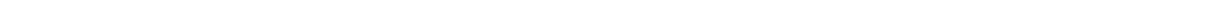
Fig. 2 Glutamylation is required for the maintenance of mouse and human pluripotency. a Mouse ESC D3 cells were transfected with scrambled shRNA (shCtrl), shCCP1, shCCP6 or CCP1 and CCP6 overexpression (oe) plasmids as indicated and cultured in mouse ESC media. After 5 days, pluripotency was analyzed by AP staining. Colony numbers for undifferentiated, mixed or differentiated clones were calculated as means ± S.D. ** P < 0.01. Scale bar, 100 μ m. n = 4. b D3 cells were transfected with the indicated plasmids and assessed AP staining as in a . ** P < 0.01. Scale bar, 50 μ m. n = 6. c Embryos at the indicated stages were isolated and stained with GT335 antibody and PI, and visualized by confocal microscopy. Scale bar, 20 μ m. Percentages of cells with GT335 signal localized in the nucleus were counted as means ± S.D. ** P < 0.01. For 1-cell-stage embryos, n = 48. For 2-cell-stage embryos, n = 56.